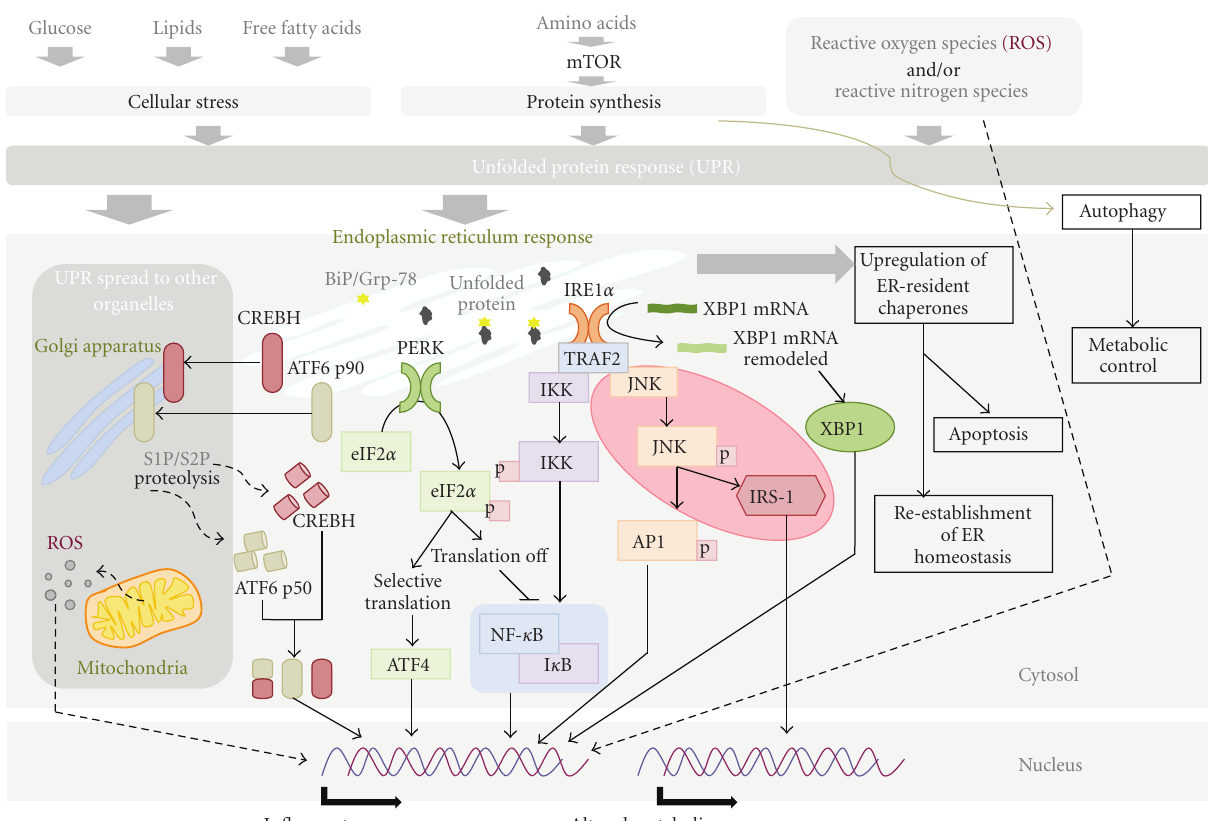
Figure 2: Inflammatory and metabolic responses may be interpreted as a response to cellular stress. Cells detect and react to stress in their environment. The endoplasmic reticulum is a principal contributor due to its central role in integrating multiple metabolic signals critical for cellular